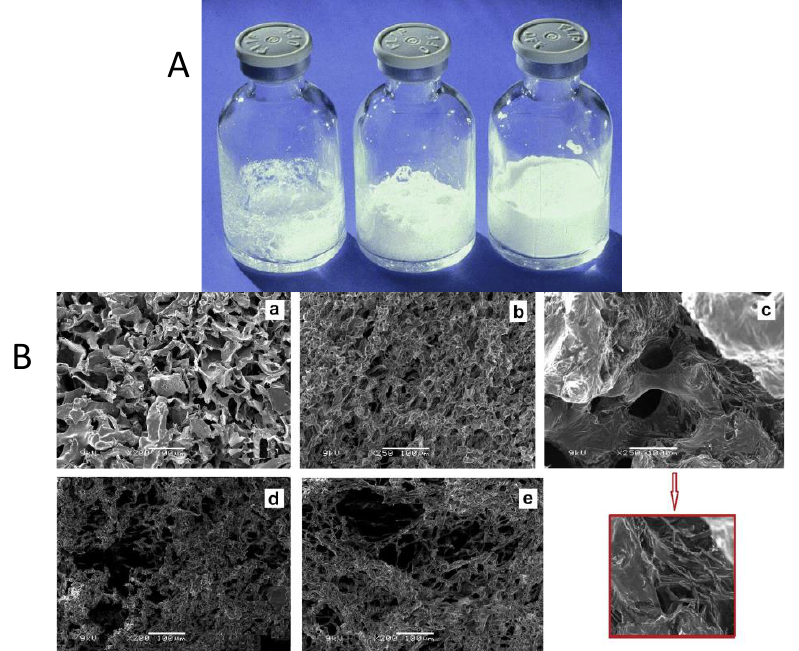
Figure 4. Possible macro and micro appearance of cakes obtained by freeze drying. ( A ) Collapsed cake: total collapse (left) and partial collapse (center). The vial on the right shows no evidence of collapse; ( B ) SEM images of freeze-dried liposomes in presence of trehalose (S:L = 5:1) with a 200 times magnification ( a ); in presence of sucrose (S:L = 5:1) with a 250 times magnification ( b ); in presence of sucrose and mannitol (S:L = 5:1) with a 250 times magnification; no lyoprotectant (control) with a 200 times magnification ( d ); in presence of trehalose (S:L = 3:1) with a 200 times magnification, ( e ) respectively. S:L represents the carbohydrate to lipid molar ratio. The insert in red highlights the crystallized mannitol in sample ( c ). Reproduced with permission from [50,51], Elsevier Inc., 2018.